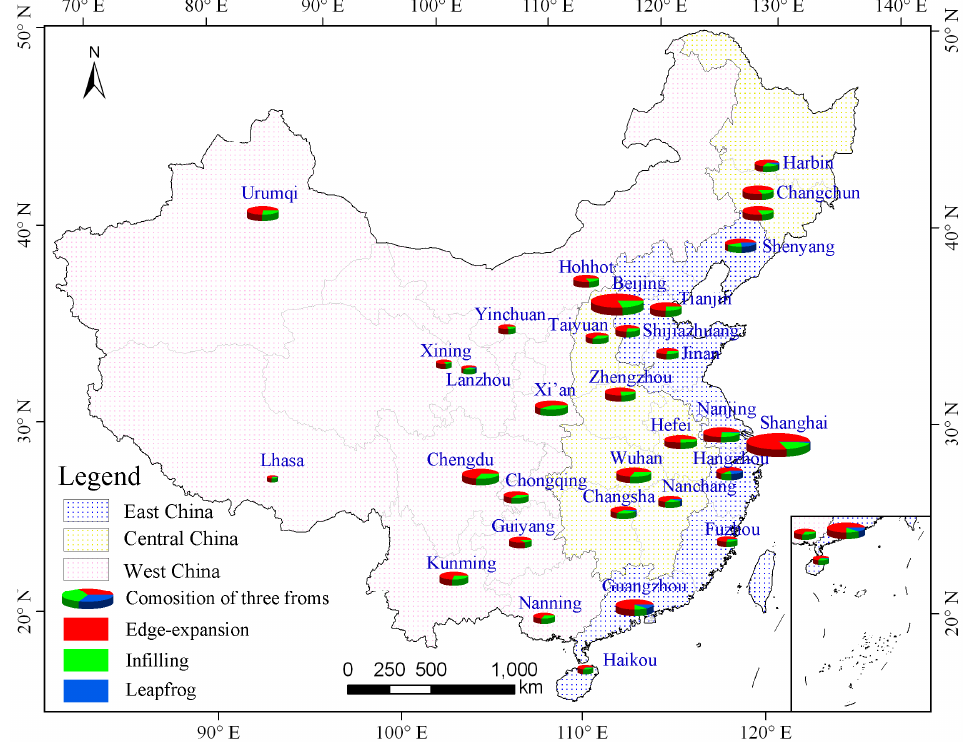
Figure 6. The composition of three urban expansion forms in the 31 sample cities from the 1970s to 2013.